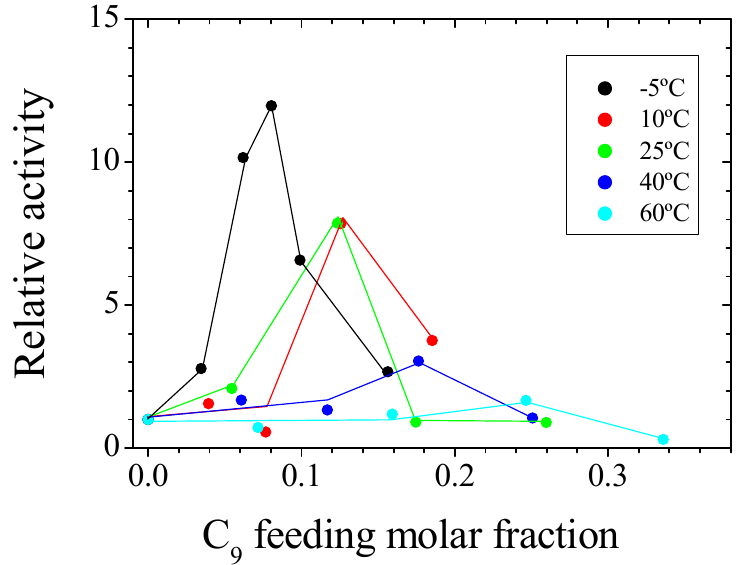
Figure 5. Evolution of relative activities with the C 9 feeding molar fraction. Polymerization runs are distinguished by the colour code inserted.